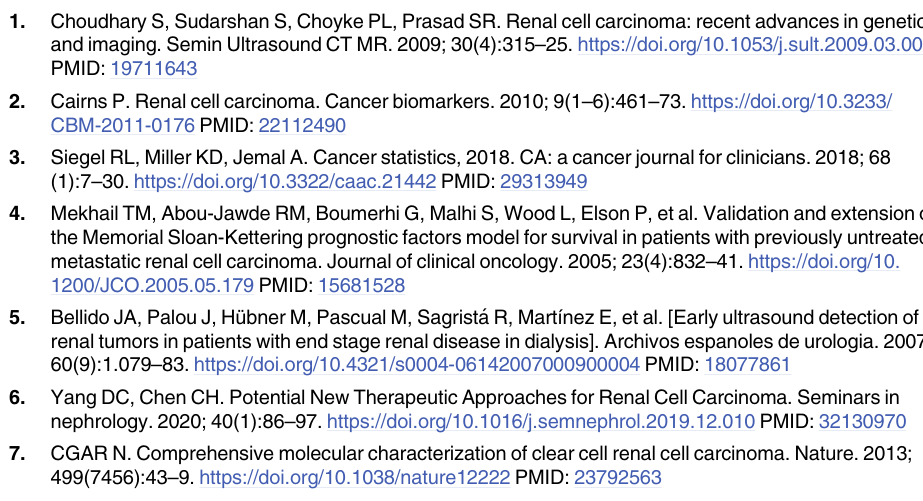
S1 Fig. Expression heatmap of PLAUR coexpressed